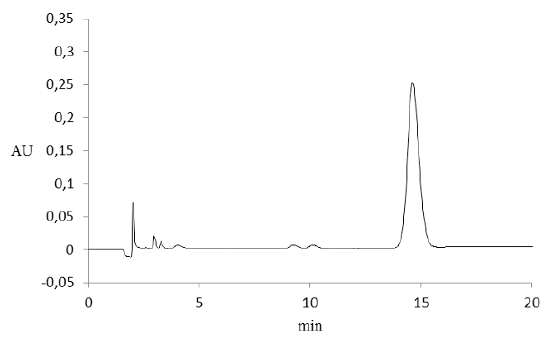
Figure 3. The HPLC chromatogram of cefoselis sulphate (retention time 14.58 min) in the presence of degradation products (retention time from 1.95 to 9.97 min) following incubation at 0.3 mol L -1 HCl at 323 K for 40 min.